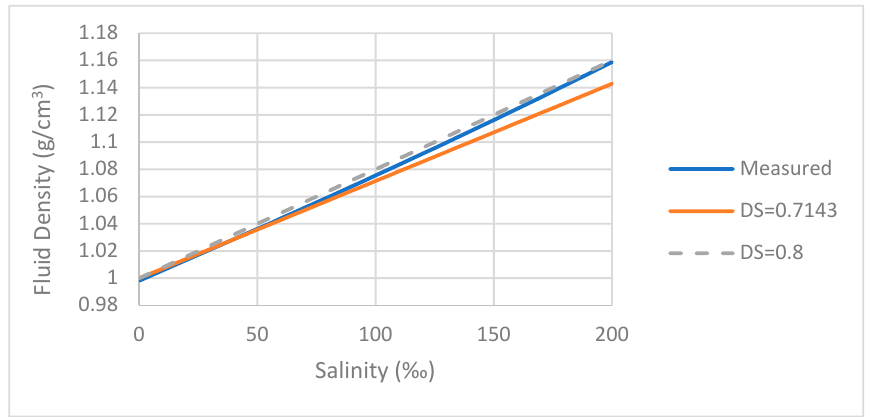
Figure 3. Comparison of measured and estimated fluid densities based on linear assumption (Equation (10)).